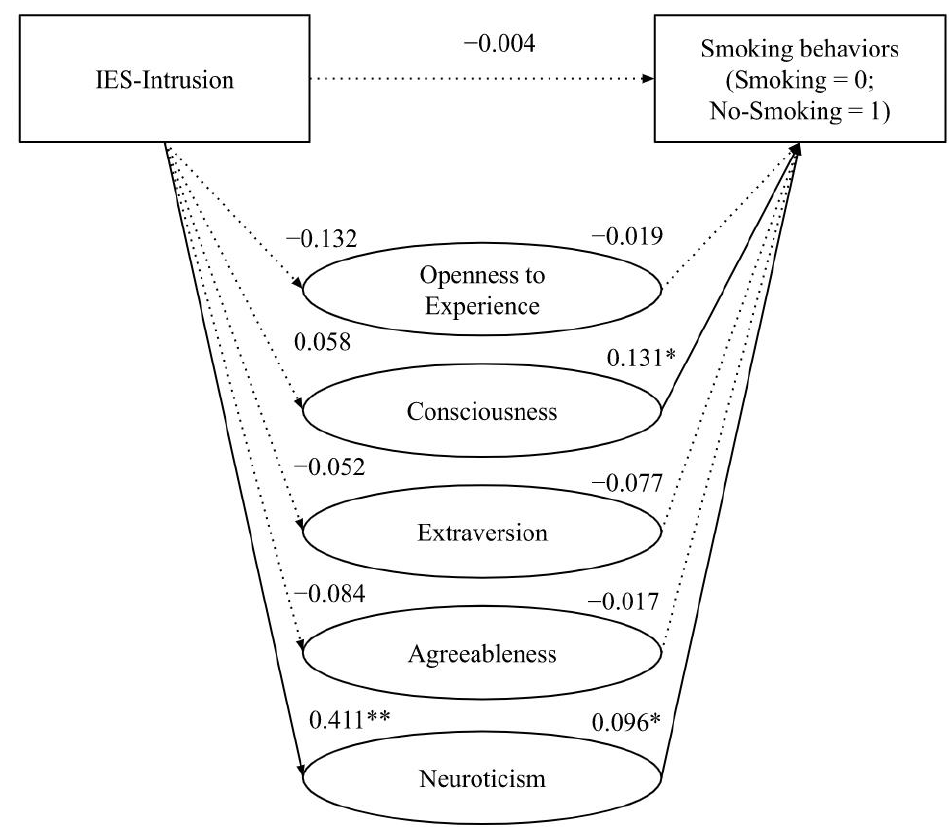
Figure 3. Partial mediation effect of personality on the relationship between intrusion and smoking behaviors. Note . ** p < 0.01; * p <